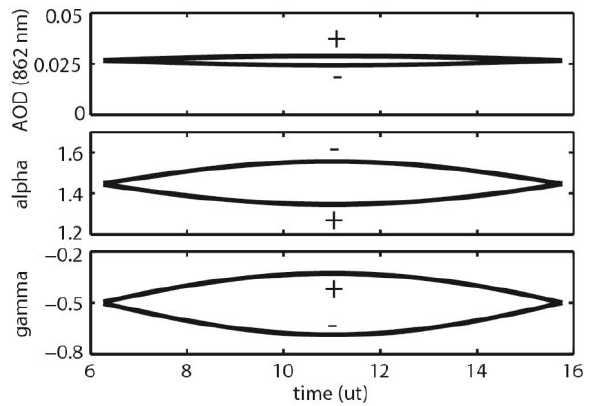
Fig. 2. Calibration error effect in the AGa representation of V 0 V 0 + σ in each individual PFR-SPM channel (colored lines) and that of an ensemble of 100 normally distributed random V 0 errors in all channels (black